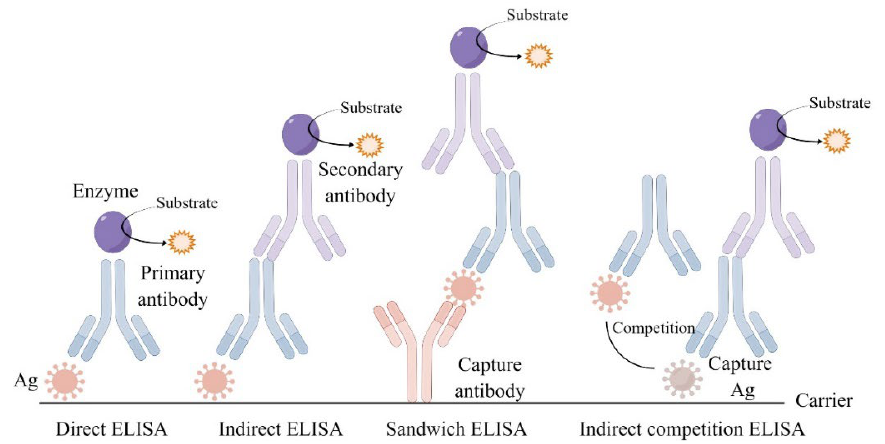
Figure 2. The type of enzyme-linked immunosorbent assay (ELISA). Note: Ag: Antigen.